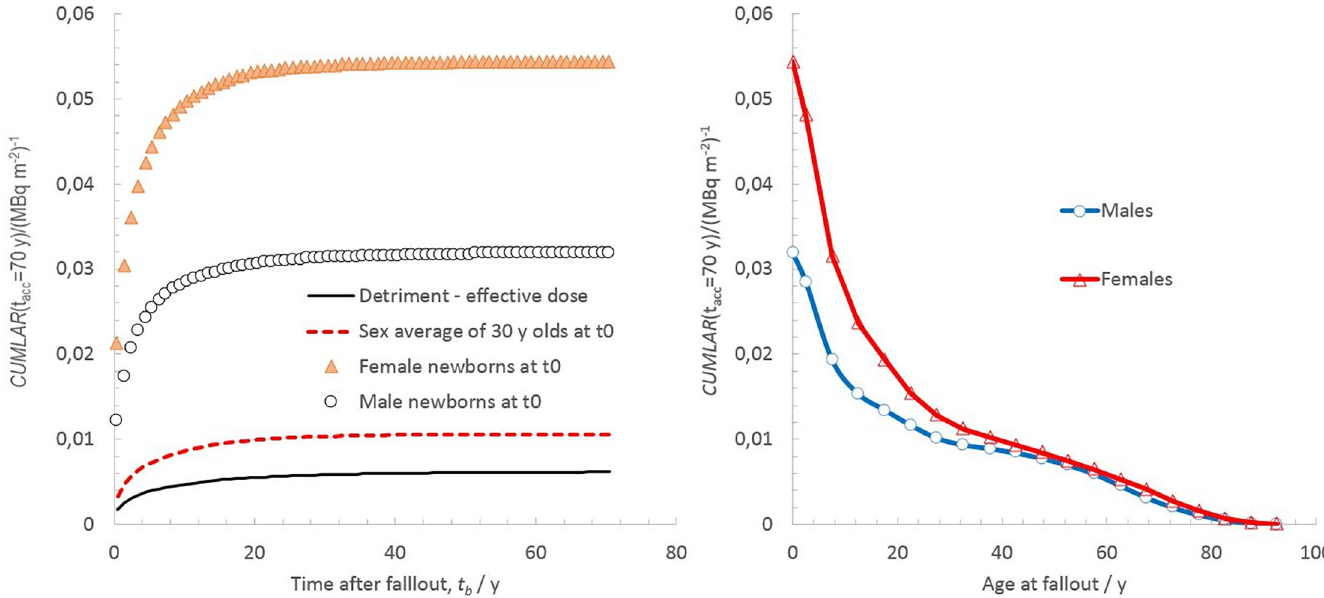
Fig 3. Cumulated lifetime attributable risk of total cancer (excluding non-fatal skin cancers) for A and males at the onset of fallout and the sex-average CUMLAR WB (70 y) for 30 y olds at t 0 , and the corresponding detriment calculated from effective dose. Right: CUMLAR WB (70 y) as a function of age at the time of fallout for the scenario of A tot , reg = 1 MBq m -2 given in Table 5.